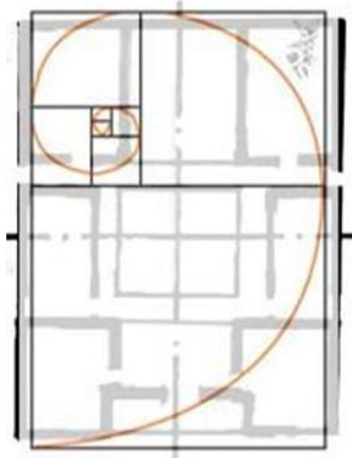
Figure 8. Floorplan of historic residence conforms to the golden ratio